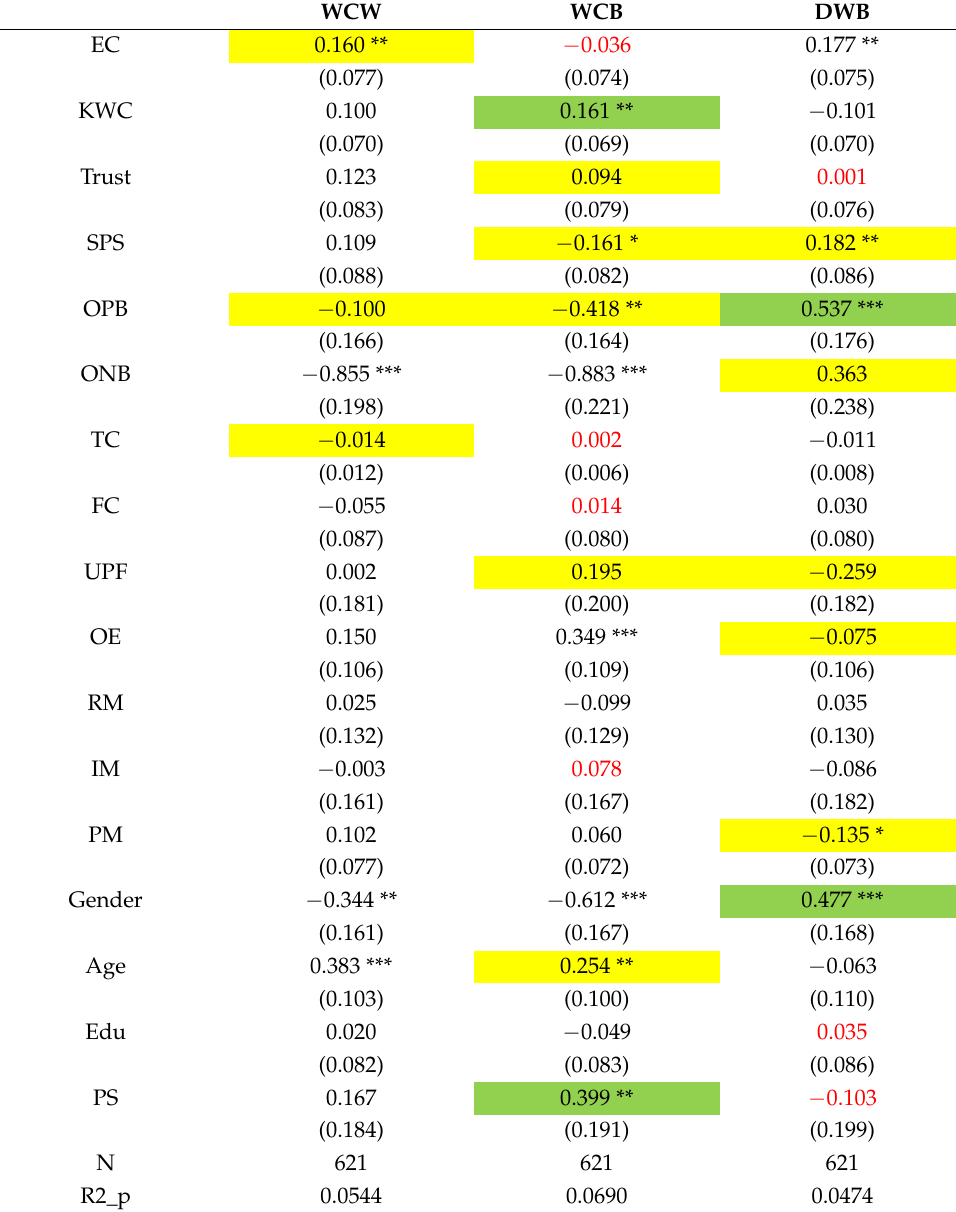
Table 6. The results of ordered logit model without income